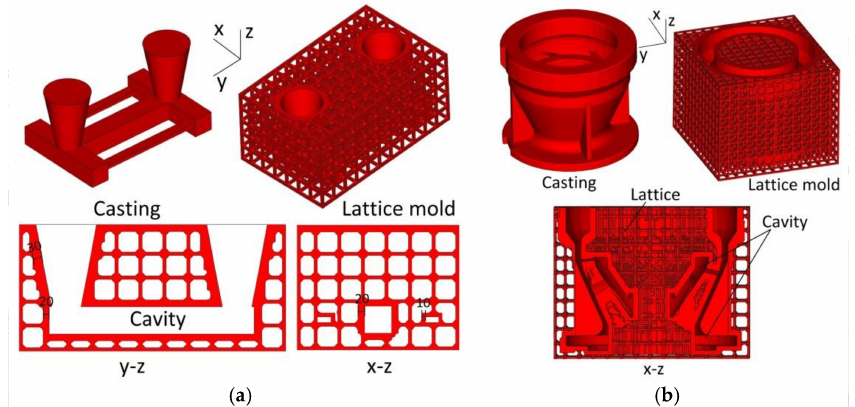
Figure 6. Examples of: ( a ) Stress frame casting; and ( b ) Pump bowl casting.